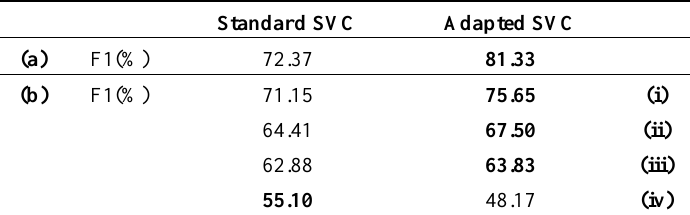
Table 2. Averaged F1 accuracies of the discrete shrub cover maps derived from standard SVC (left) and adapted SVC (right) ( a ) for the entire study area and ( b ) for selected subsets. Statistics for the entire study area are derived from mean values of 200 iterations for an equalized random sample of 731 observations for each decile ( cf. Section 3.3). Higher accuracy values are highlighted.